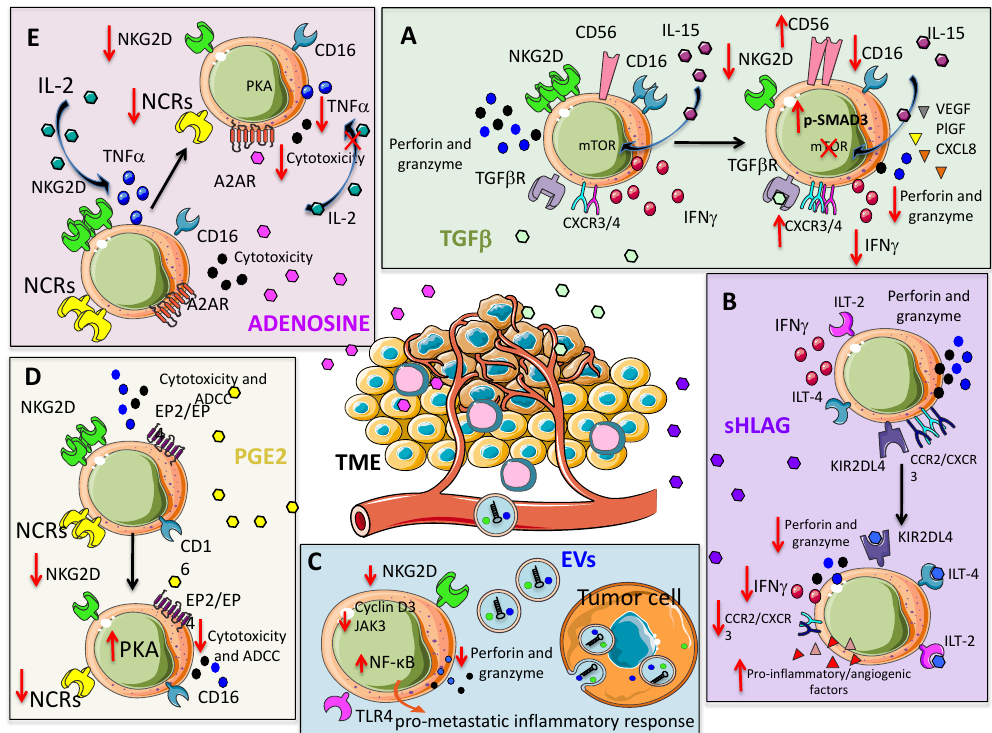
Figure 1. Soluble factors within the tumor microenvironment (TME) orchestrating natural killer (NK) cell pro-tumor features. Several soluble or microvesicle/exosome-associated factors can impair NK cell-mediated anti-tumor activities. These factors can be produced by different components of the TME besides tumor cells. ( A ) TGF- β can inhibit interleukin-15 (IL-15) triggering of NK cells, impairing the mTOR signaling; this results in the reduction of NKG2D expression and consequent killing of NKG2DL + tumor cells; also, CD16, perforins, granzymes and IFN- γ are downregulated. This revert NK cells to a pro-angiogenic phenotype characterized by the secretion of VEGF. ( B ) Soluble HLA-G interacting with the KIR2DL4, ILT-4 and ILT-2 inhibitory NK cell receptors shape the behavior of NK cells from cytotoxic to pro-angiogenic. ( C ) Tumor-derived extracellular vesicles (EVs) and exosomes expressing NKG2DL can induce NK cell anergy because they interact with NKG2D on NK cell surface; this impairs the binding of NK cells with NKG2DL present on tumor cells. ( D ) PGE 2 recognizes EP2/EP specific receptors on cytotoxic NK cells leading to the decrement of expression of several activating receptors such as NKG2D and NCR. This leads to the inhibition of tumor target recognition and killing. ( E ) Likewise, PGE 2 , adenosine upon binding with A2AR receptors on NK cells induces the downregulation of NKG2D and NCR; this results in a reduced killing of tumor target cells expressing NKG2DL and/or